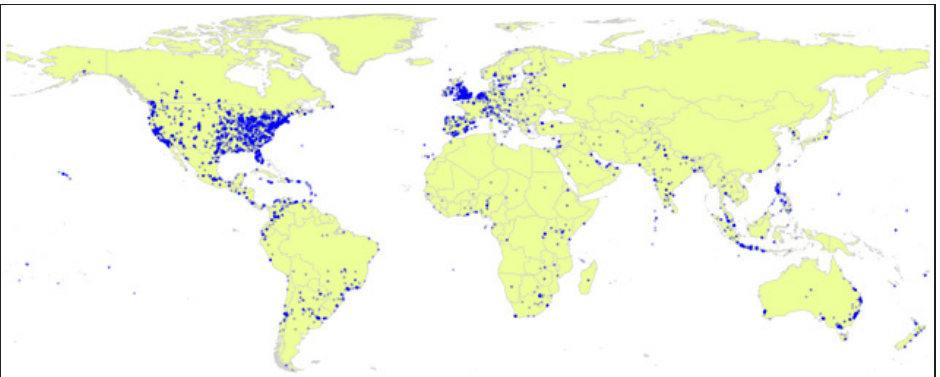
Figure 1: Visualisation of geographic distribution of geotagged tweets about climate change (0.9% from 897.306 tweets) posted in 2014. Python scripts were used to gather tweets (from Twitter Decahose) and to extract metadata. The coordinates extracted from geotagged tweets were visualised on the world map with the open-source software QGIS (Brantner & Pfeffer,